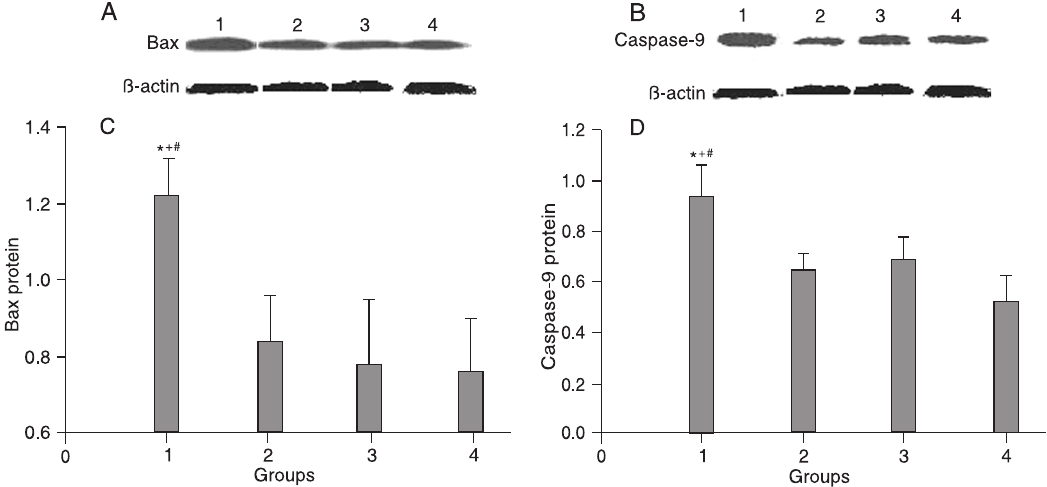
Figure 7. Effect of TRAIL and/or ADM treatment on protein levels of Bax and caspase-9 in MCF-7 cells. Panels A and C , Bax; panels B and D , caspase-9. Cells were treated with TRAIL (0.1 µg/mL) or/and ADM (0.5 µg/mL) for 24 h and the expression of Bax and cas- pase-9 proteins was determined by Western blot analysis. The relative amount of each protein was compared to β-actin. TRAIL = tumor necrosis factor-related apoptosis-inducing ligand; ADM = adriamycin. Lane 1 , TRAIL plus ADM; lane 2 , ADM alone; lane 3 , TRAIL alone; lane 4 , negative control. * P < 0.05 compared to the negative control group; + P < 0.05 compared to the TRAIL alone group; # P < 0.05 compared to the ADM alone group (Student t